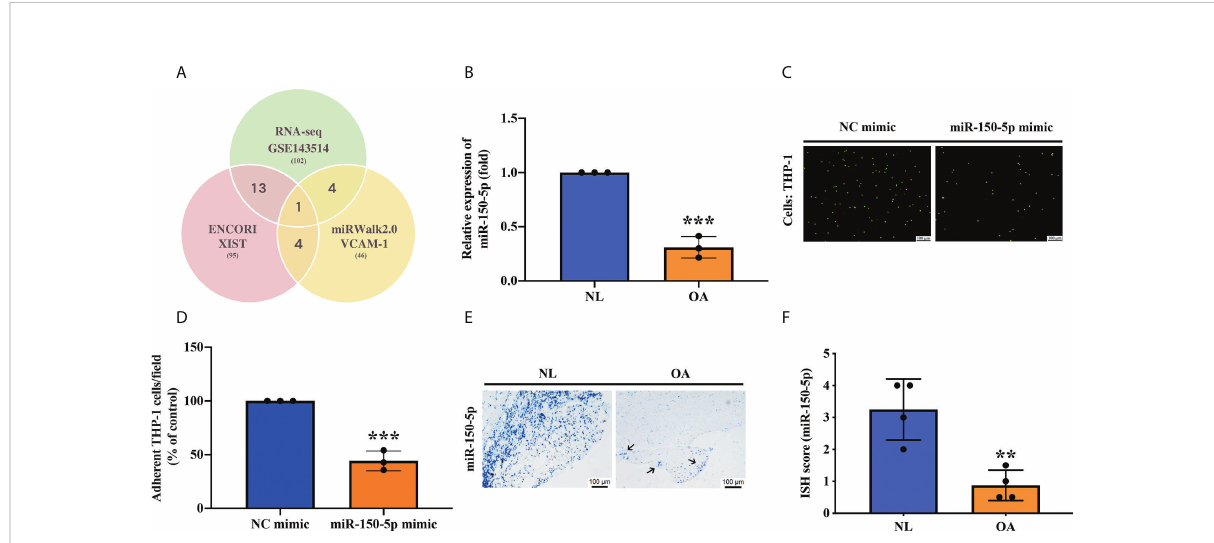
FIGURE 3 miR-150-5p is downregulated in OA synovial tissue and promotes monocyte adherence. (A) The schematic for miRNA fi ltering: miRNA-seq analysis identi fi ed downregulated levels of miRNA expression in OA synovial tissue. Open-source platforms ENCORI and miRWalk2.0 were analyzed to predict miRNAs that target VCAM-1 and XIST. (B) RT-qPCR revealed levels of miR-150-5p expression in 3 samples of normal healthy synovial tissue and 3 samples of OA synovial tissue. (C, D) OASFs were transfected with miR-150-5p mimic for 24 h. BCECF-AM labeled THP-1 cells (2×10 (4) cells/ml) were incubated with OASFs for 1 h. The images of adherent THP-1 cells were photographed under fl uorescence microscopy and then quanti fi ed by ImageJ software in three independent experiments. (E, F) The blue dots indicate levels of miR-150-5p expression in 4 images of human synovial tissue and quanti fi cation by ISH scores, from 0 (no staining or <1 dot per cell) to 4 (>10 dots per cell and >10% positive cells had dot clusters, visible at 20x). ** p < 0.01, *** p < 0.001 compared with normal synovial tissue or control